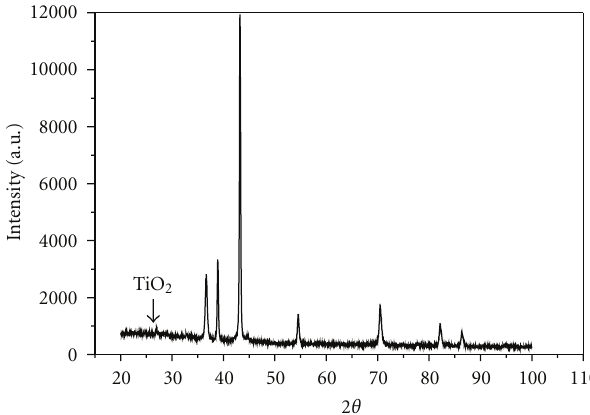
Figure 5: XRD images of composite-coated